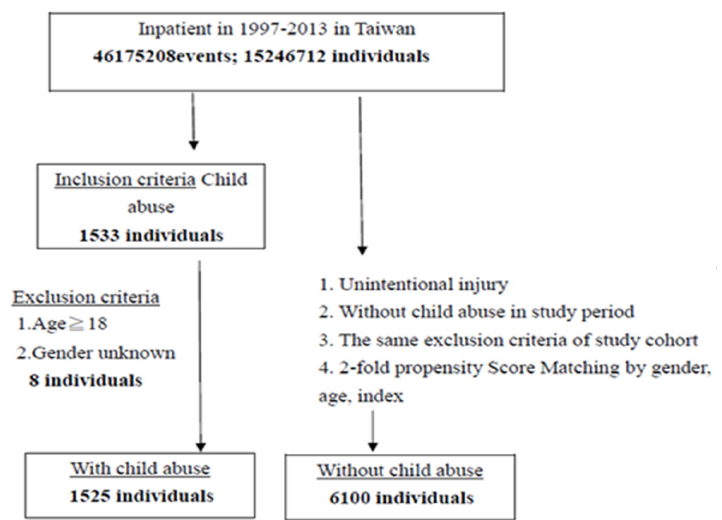
Figure 1. The flowchart of study sample selection from National Health Insurance Research Database in Taiwan.